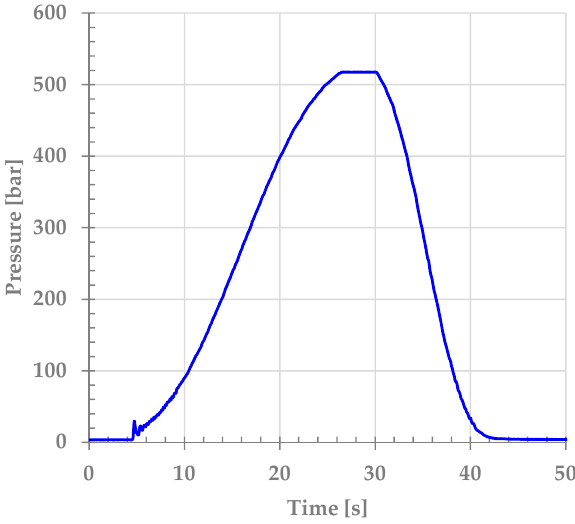
Figure 11. Burst pressure test: load profile.